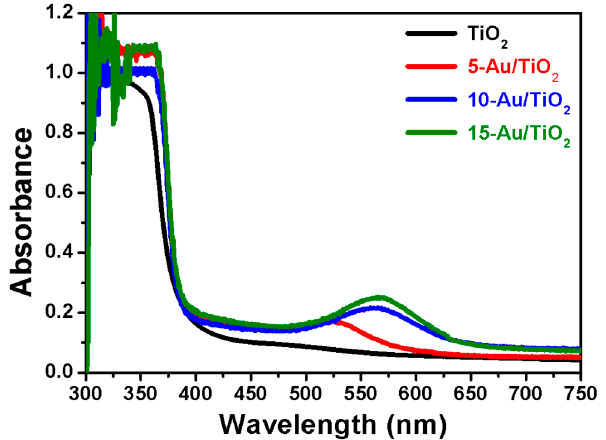
Figure 6. Di ff use reflectance absorption spectra of pure TiO 2 NFs and Au / TiO 2 NFs with di ff erent UV Figure 6. Diffuse reflectance absorption spectra of pure TiO 2 NFs and Au/TiO 2 NFs with different UV illumination illumination times.